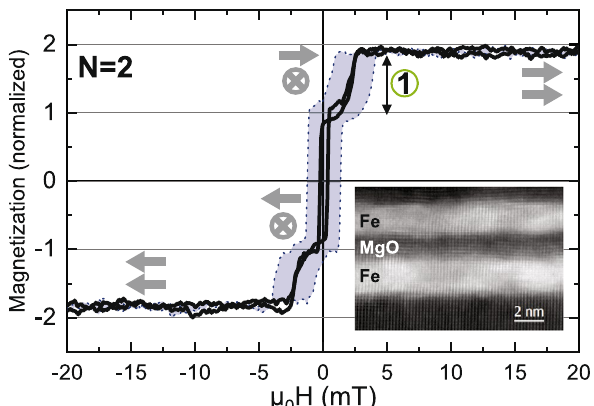
Figure 2. Magnetization measurements along the in-plane easy axis (Fe[100]) of a [Fe/MgO] 2 sample. The outline of the blue area marks the measured hysteresis loop whereas in the black curve the coercivity of the Fe layers has been removed. Possible magnetic states are indicated by gray arrows. The layering and the crystallinity of the Fe(001) and MgO(001) lattice is illustrated by a HAADF STEM image of the N = 2 sample (inset).